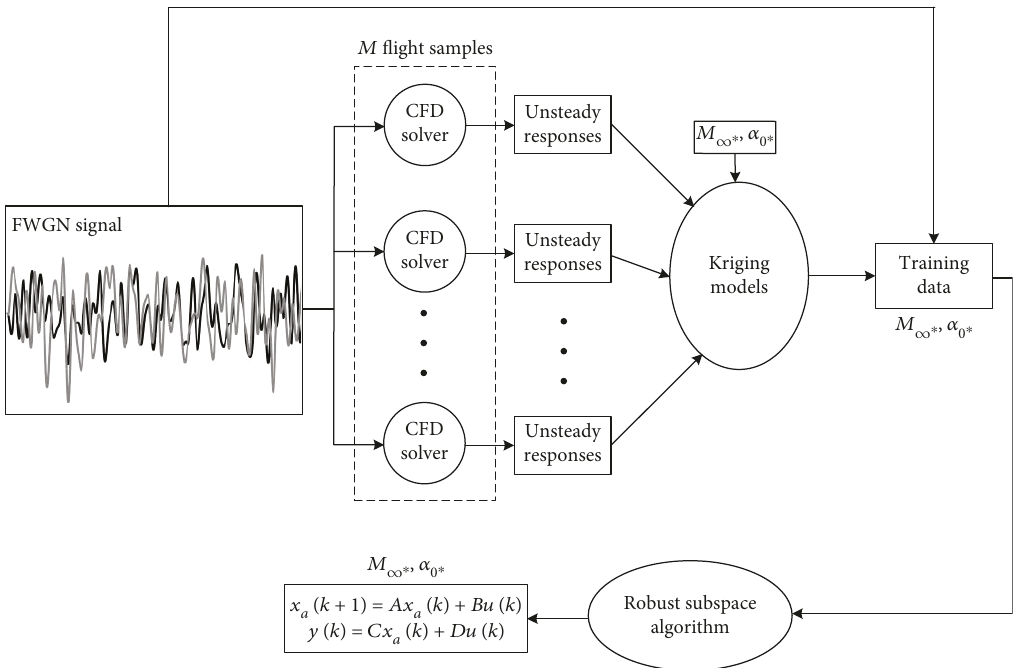
Figure 1: The fl owchart of the reduced-order modeling